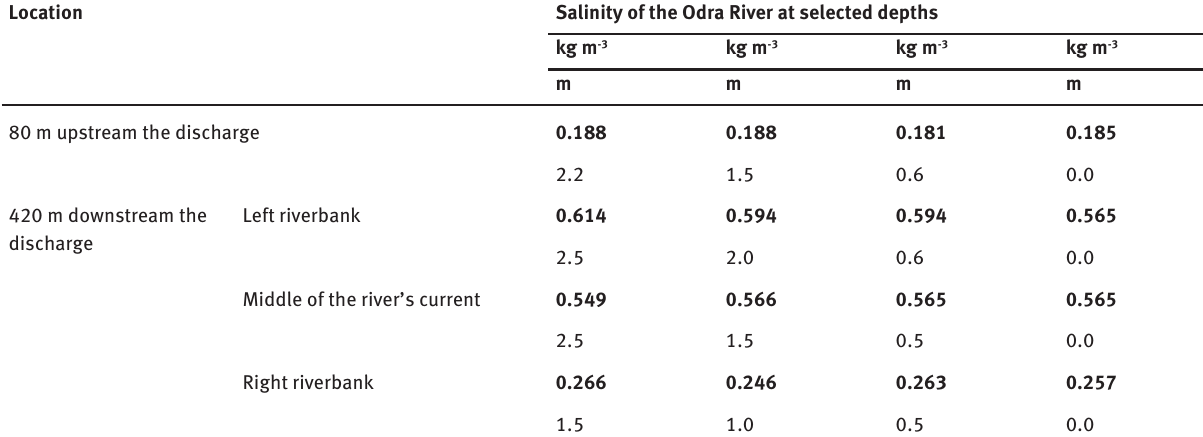
Table 2: Measured values of the brine concentration at selected depths in the Odra River upstream and downstream the discharge. Location Salinity of the Odra River at selected depths kg m -3 kg m -3 kg m